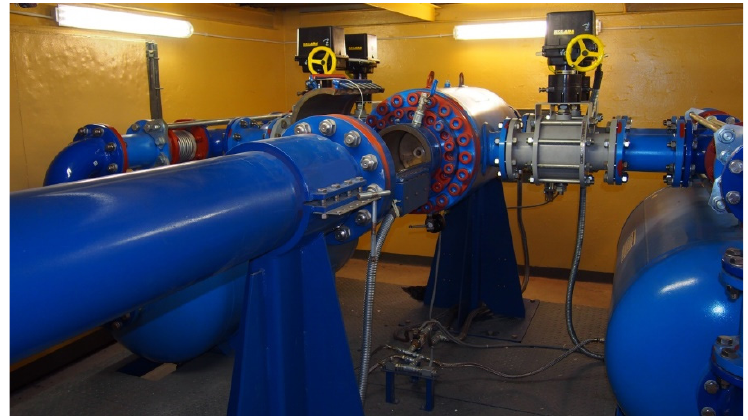
Figure 6. Gas gun DPZ-250.